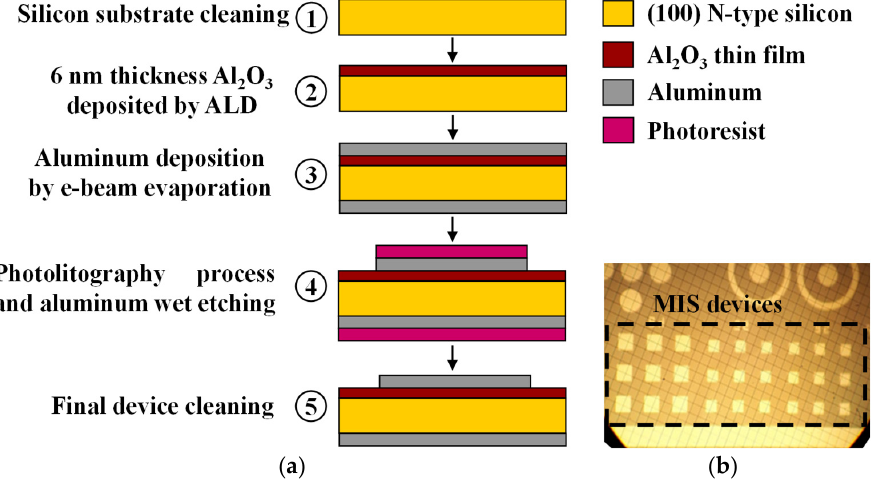
Figure 1. ( a ) Schematic diagram of fabrication process of MIS devices, and ( b ) photograph of fabricated MIS devices.